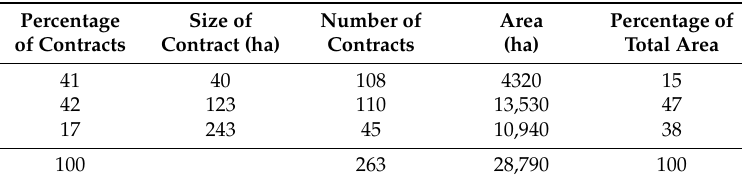
Table 2. Assumed distribution of feedstock